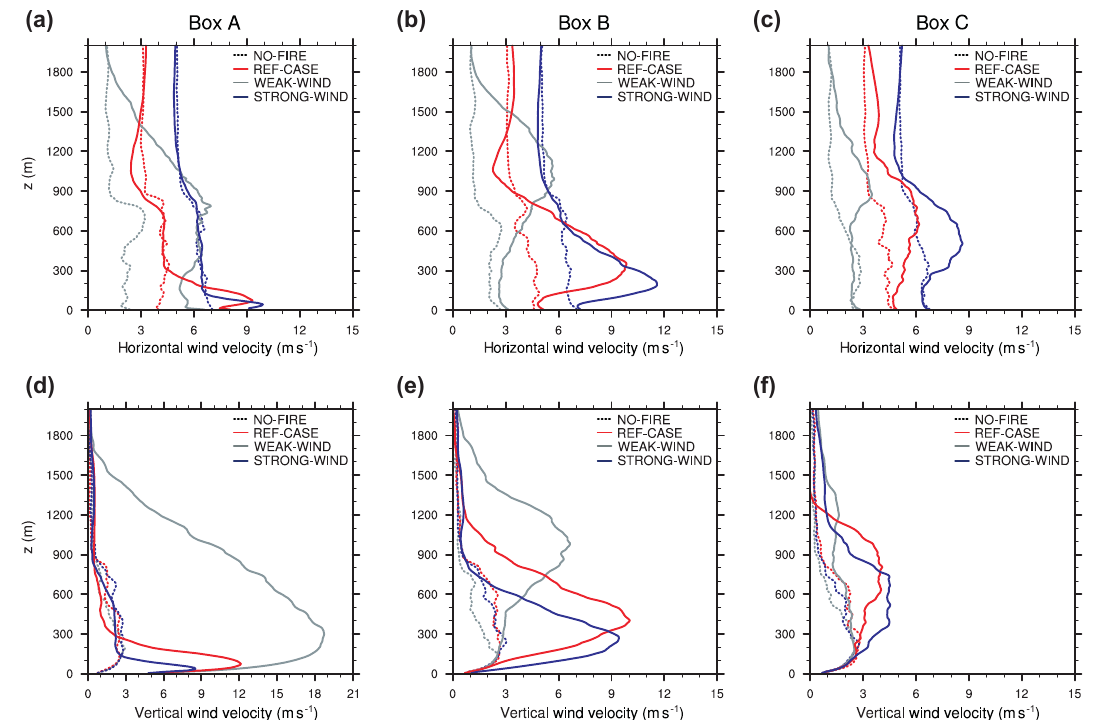
Figure 6. Vertical profiles of the horizontal (upper row) and vertical (lower row) wind velocity for the simulations with a different ambient wind velocity (WEAK-WIND, REF-CASE, and STRONG-WIND) and different distances from the fire (boxes A, B, C in Fig. 2). Shown are the atmospheric profiles after fire ignition (solid line) with the profile in the undisturbed non-fire situations (dashed line). Plotted are means of the maximum values per time